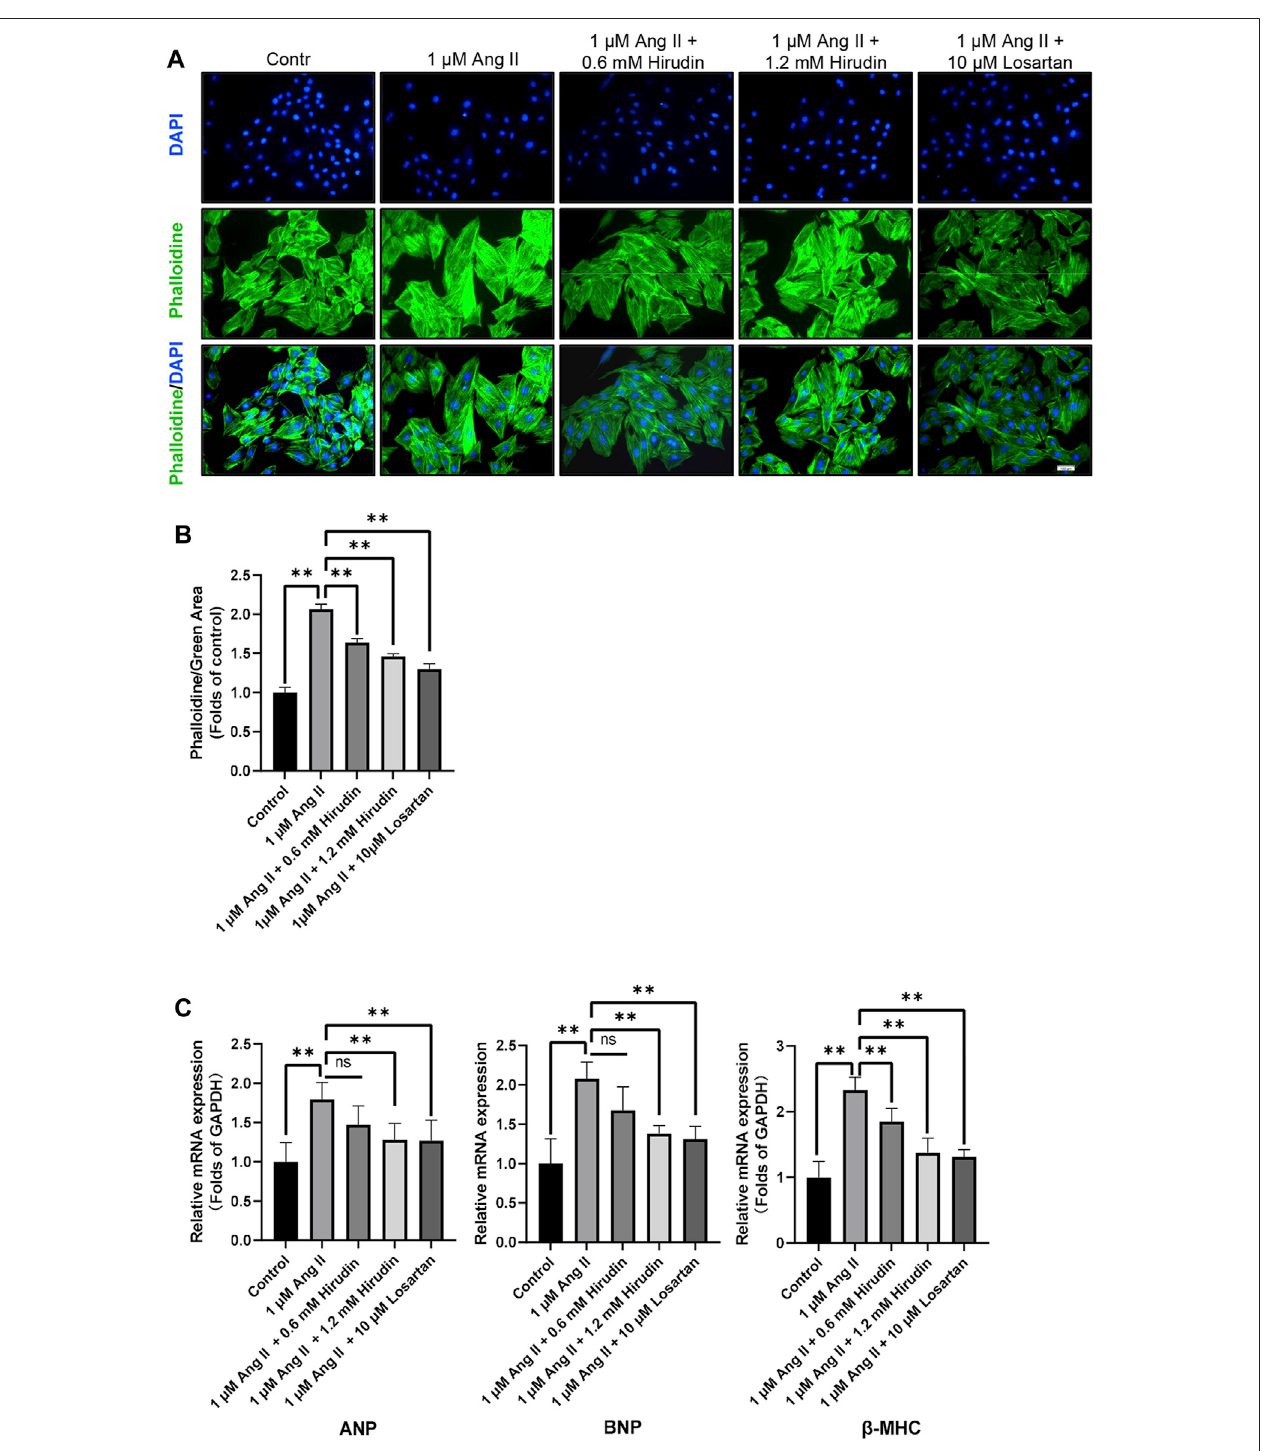
FIGURE7|(A) H9c2cellsweretreatedwith1 μ MAngII,(0.6,1.2 mM)hirudinand10 μ Mlosartanfor24 h,respectively,andthenlabeledwithphalloidinandDAPI, and observed by fl uorescence microscope, magni fi cation: × 200. (B) Green area for analysis of phalloidin. Bars represent the mean ± SD, n = 3. (C) The expression of ANP, BNP, and β -MHC was analyzed by qRT-PCR, n = 6 ** p < 0.01.